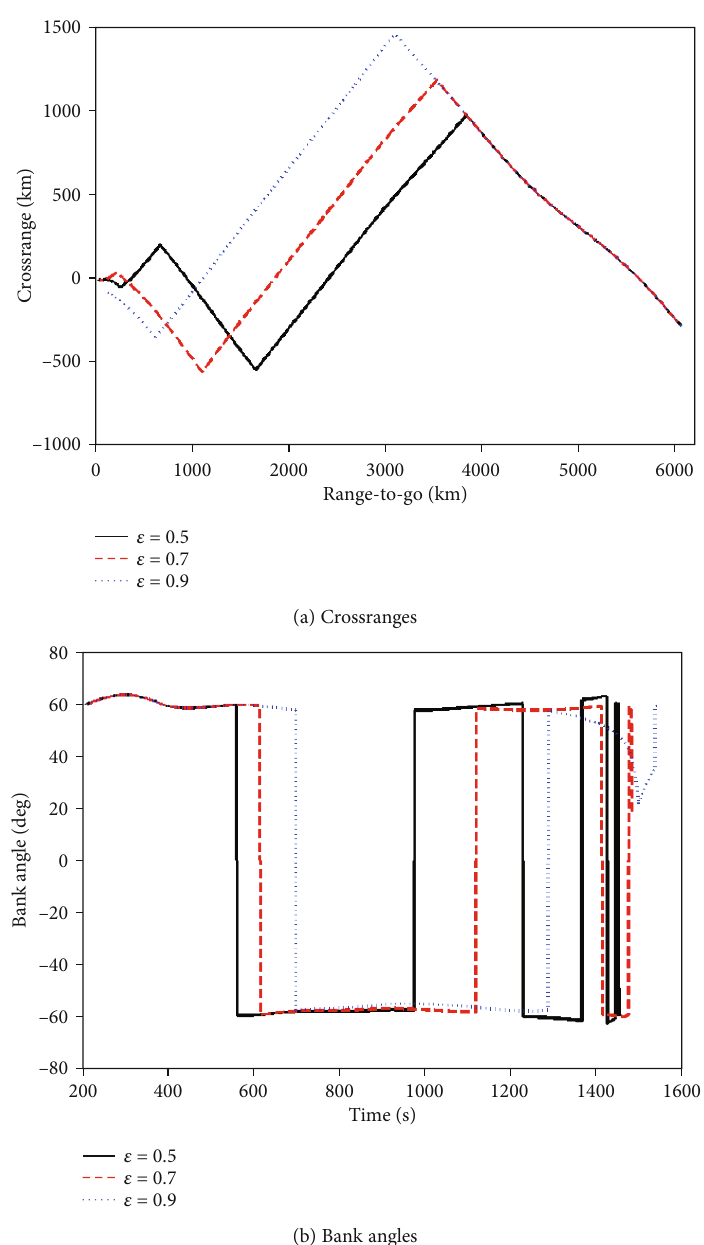
Figure 3: Crossranges and bank angles of the AANLL for di ff erent ε